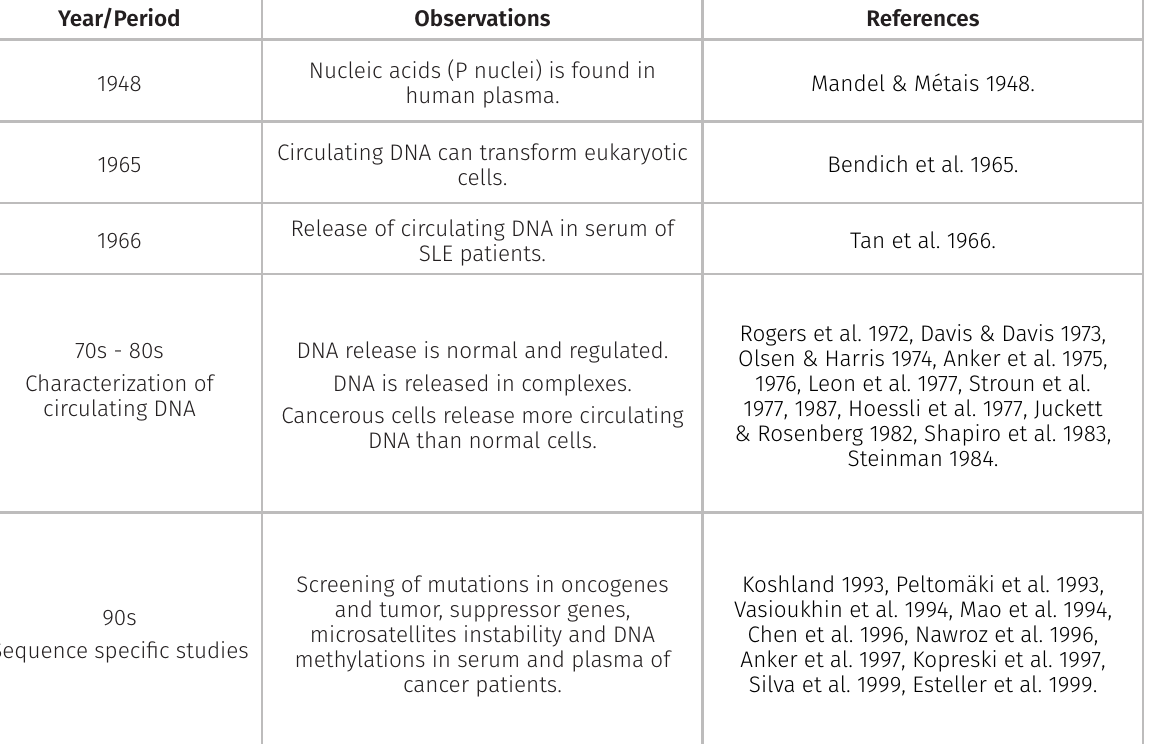
DNA is released in